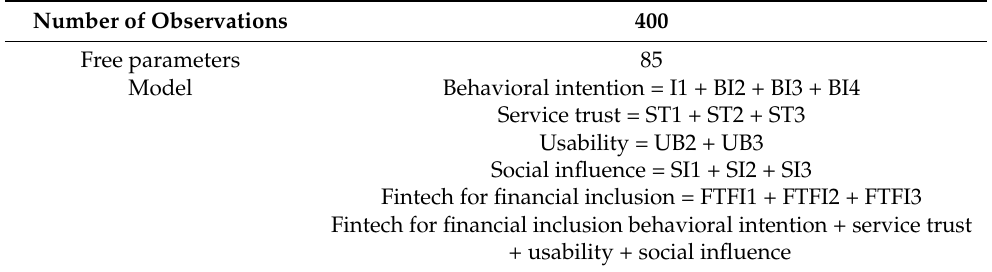
Table 2. Model information.